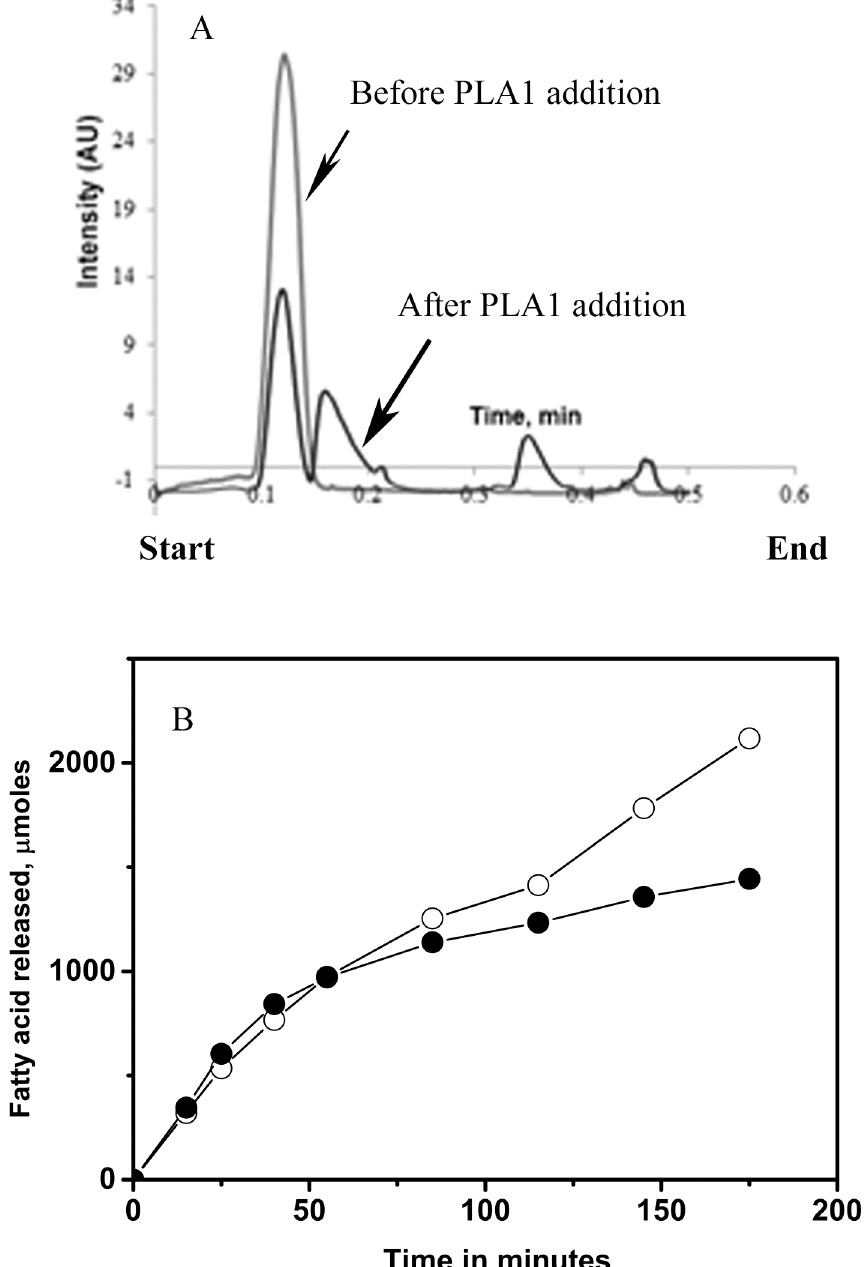
Fig 2. Time course of hydrolysis of anchovy fish oil by PLA1 and BSL. A, Iatroscan of unhydrolysed (light trace) and hydrolysed (darker trace) fraction of anchovy oil by PLA1. Start and the end of the scan are identified. B, pH stat based determination of rate of hydrolysis of anchovy oil in the presence of PLA1 (closed circle) and BSL (open circle).